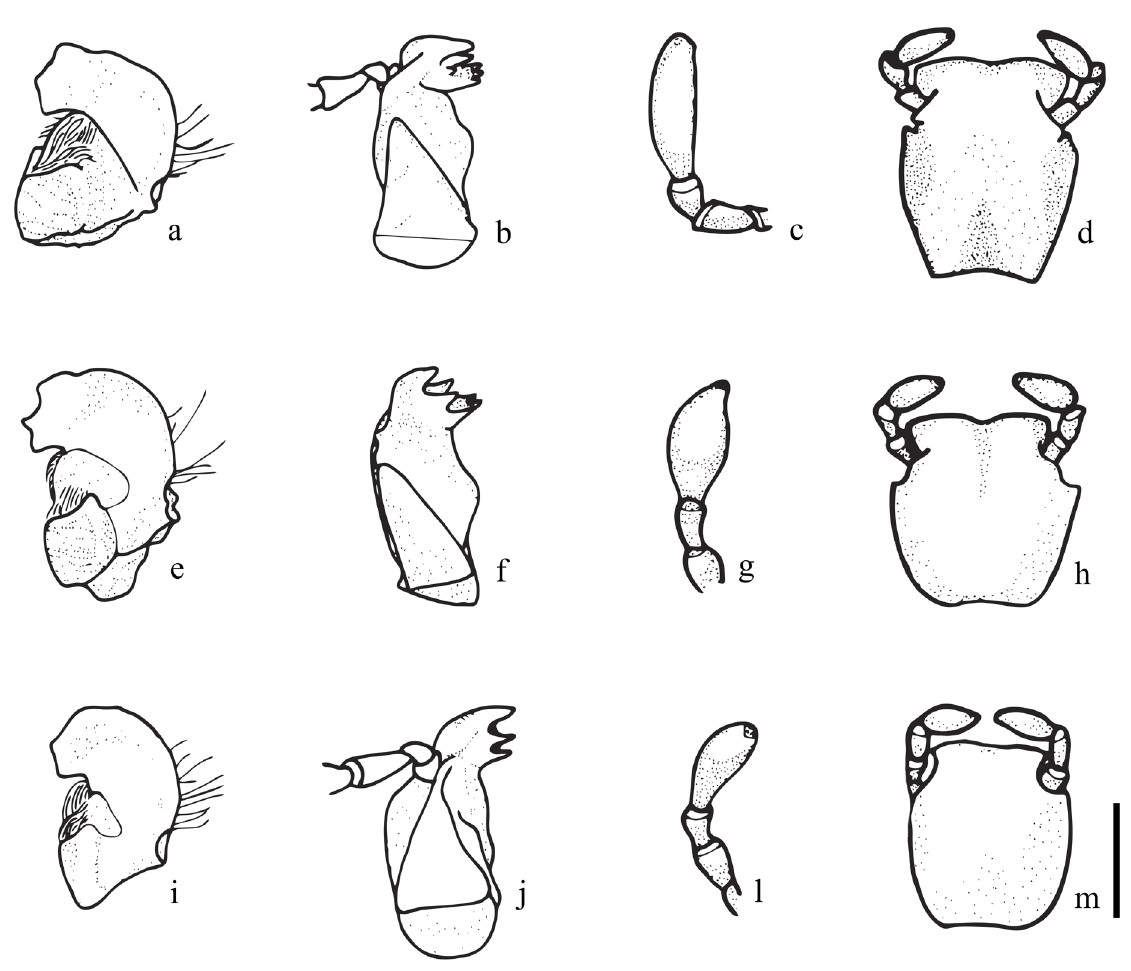
Fig. 4. Mouthparts. a–d . Oplognathus kirbii MacLeay, 1819 (ZMHB). e–h . O. bahianus Ohaus, 1912 (ZMHB). i–m . O. helmenreichi Ohaus, 1905 (ZMHB). a, e, i . Right mandible. b, f, j . Right maxilla. c, g, l . Detail of the last maxillary palpomere. d, h, m . Mentum. Scale bar = 1